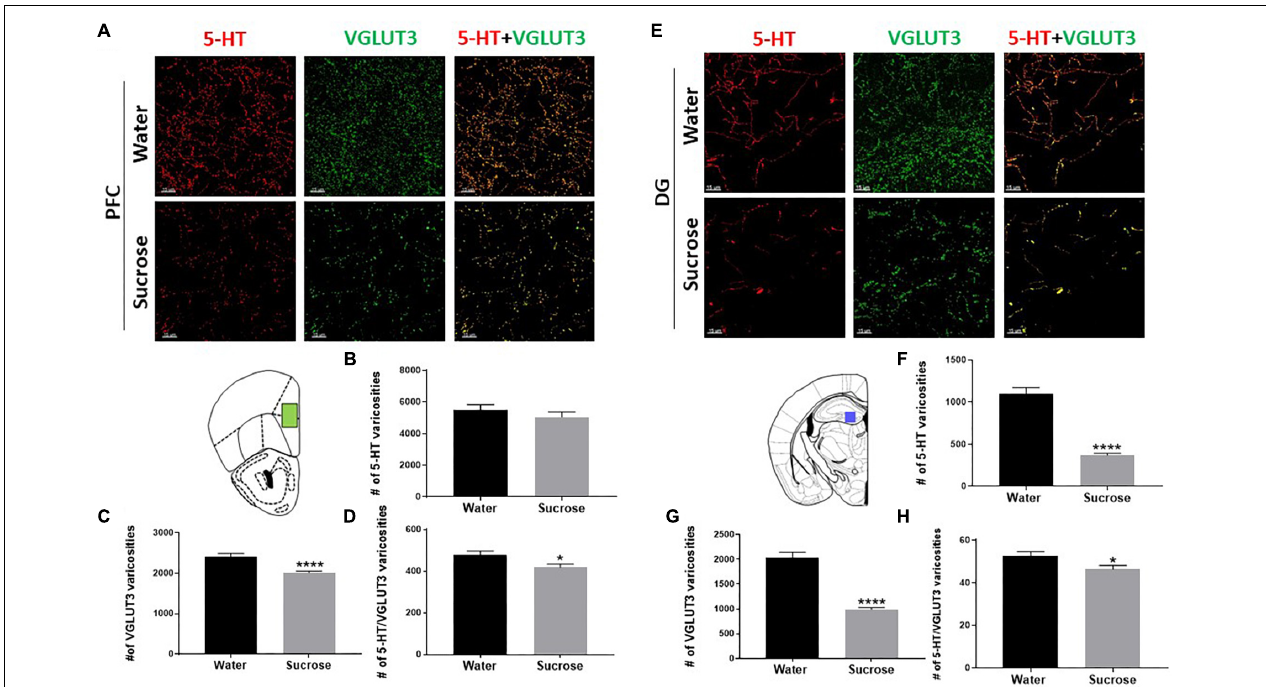
FIGURE 3 | Sucrose alters serotonin innervation in the PFC and DG of the hippocampus. A high-resolution representative image of the PFC (A) and DG of the hippocampus (E) showing the distribution of the reconstructed 5-HT, VGLUT3, and 5-HT/VGLUT3 co-localisation surfaces between water and sucrose consuming animals (Scale: 50 µ m). Sucrose drinking does not alter the density of 5-HT varicosities (B) however, decreases the density of VGLUT3 varicosities (C) and the density of 5-HT/VGLUT3 co-localised varicosities (D) in the PFC. Sucrose drinking selectively decreases the density of varicosities of 5-HT (F) , density of VGLUT3 varicosities (G) and density of 5-HT/VGLUT3 (H) co-localised varicosities in the DG of the hippocampus. Data are presented as mean ± S.E.M ( t -test); n = 8 mice/group. * p < 0.05, **** p < 0.0001. PFC, prefrontal cortex; DG, dentate